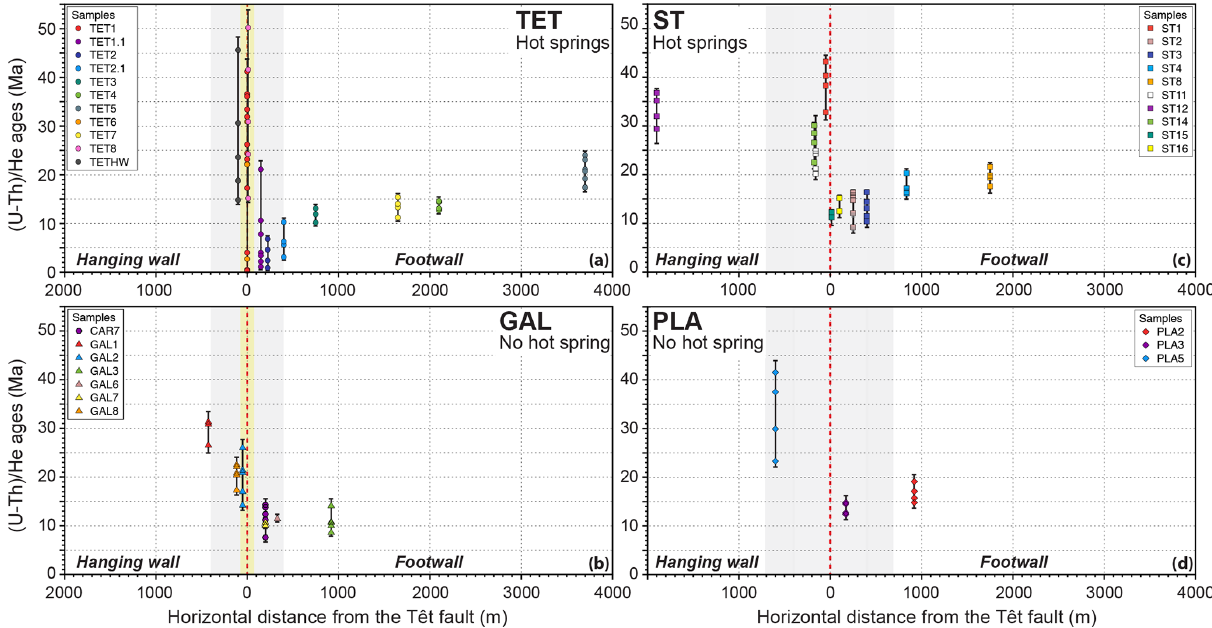
Figure 7. AHe ages as a function of the horizontal distance from the Têt fault. Grey area shows the damage zone of the Têt fault; an inner DZ (yellow) is only distinguished for the TET and GAL profiles according to Milesi et al.